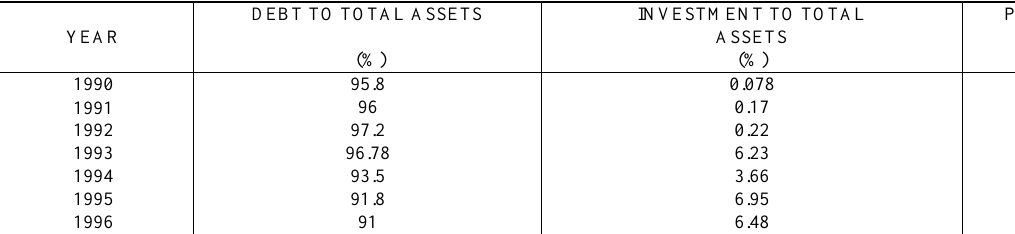
TABLE 12: UNION BANK